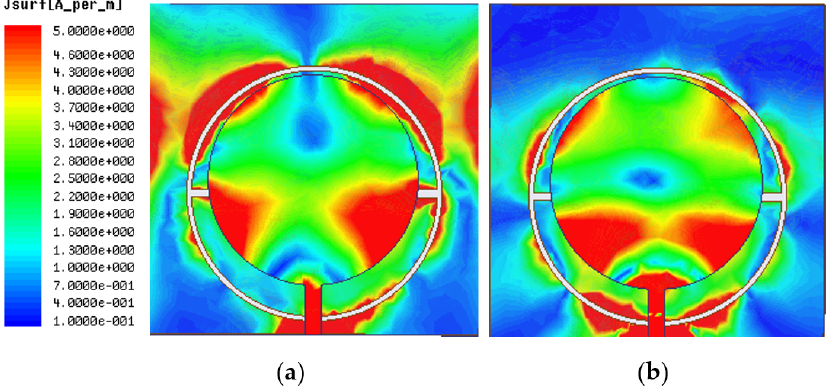
Figure 7. Current distribution of the proposed antenna. ( a ) 2.43 GHz. ( b ) 5.2 GHz.